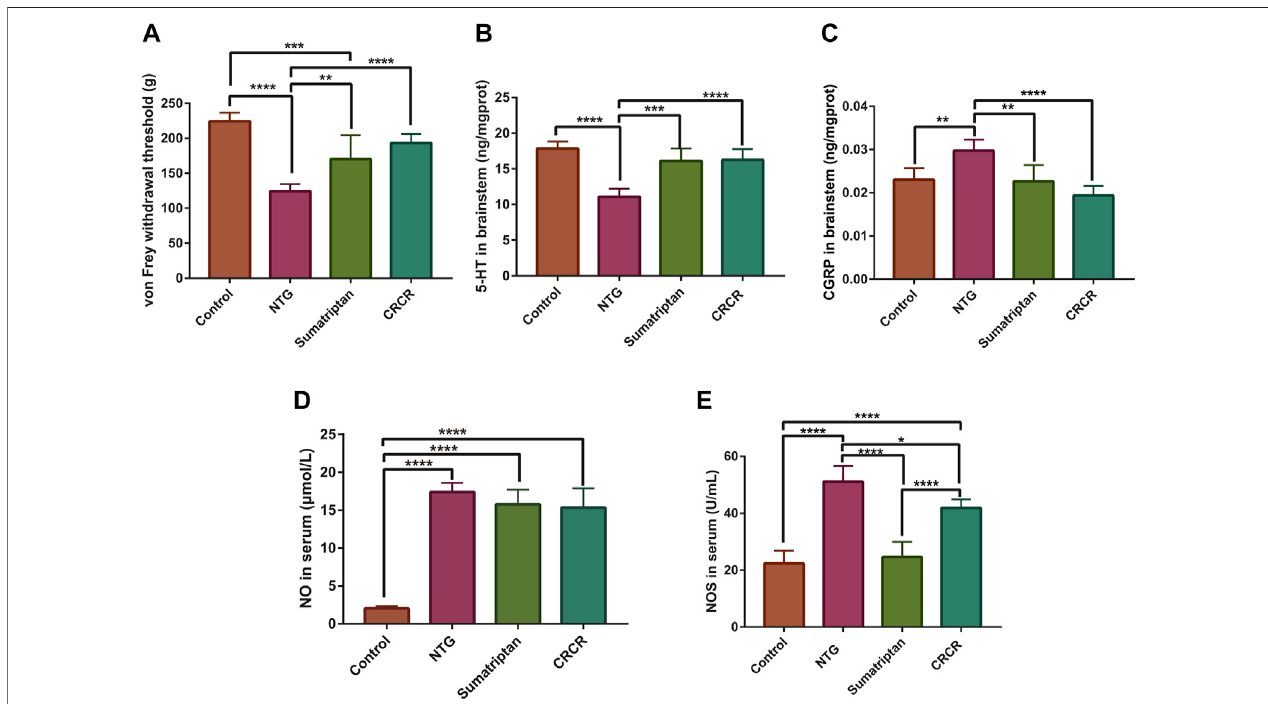
FIGURE2| Measurementofmechanicalthresholdsandpharmacologicalindexes. (A) ThethresholdsofvonFreymechanicalstimulation. (B) 5-Hydroxytryptamine (5-HT)intheratbrainstem. (C) Calcitoningene-relatedpeptide(CGRP)intheratbrainstem. (D) Nitricoxide(NO)intheratserum. (E) Nitricoxidesynthase(NOS)intherat serum. Data are expressed as mean ± S.D. * p < 0.05, ** p < 0.01, *** p < 0.001, **** p <